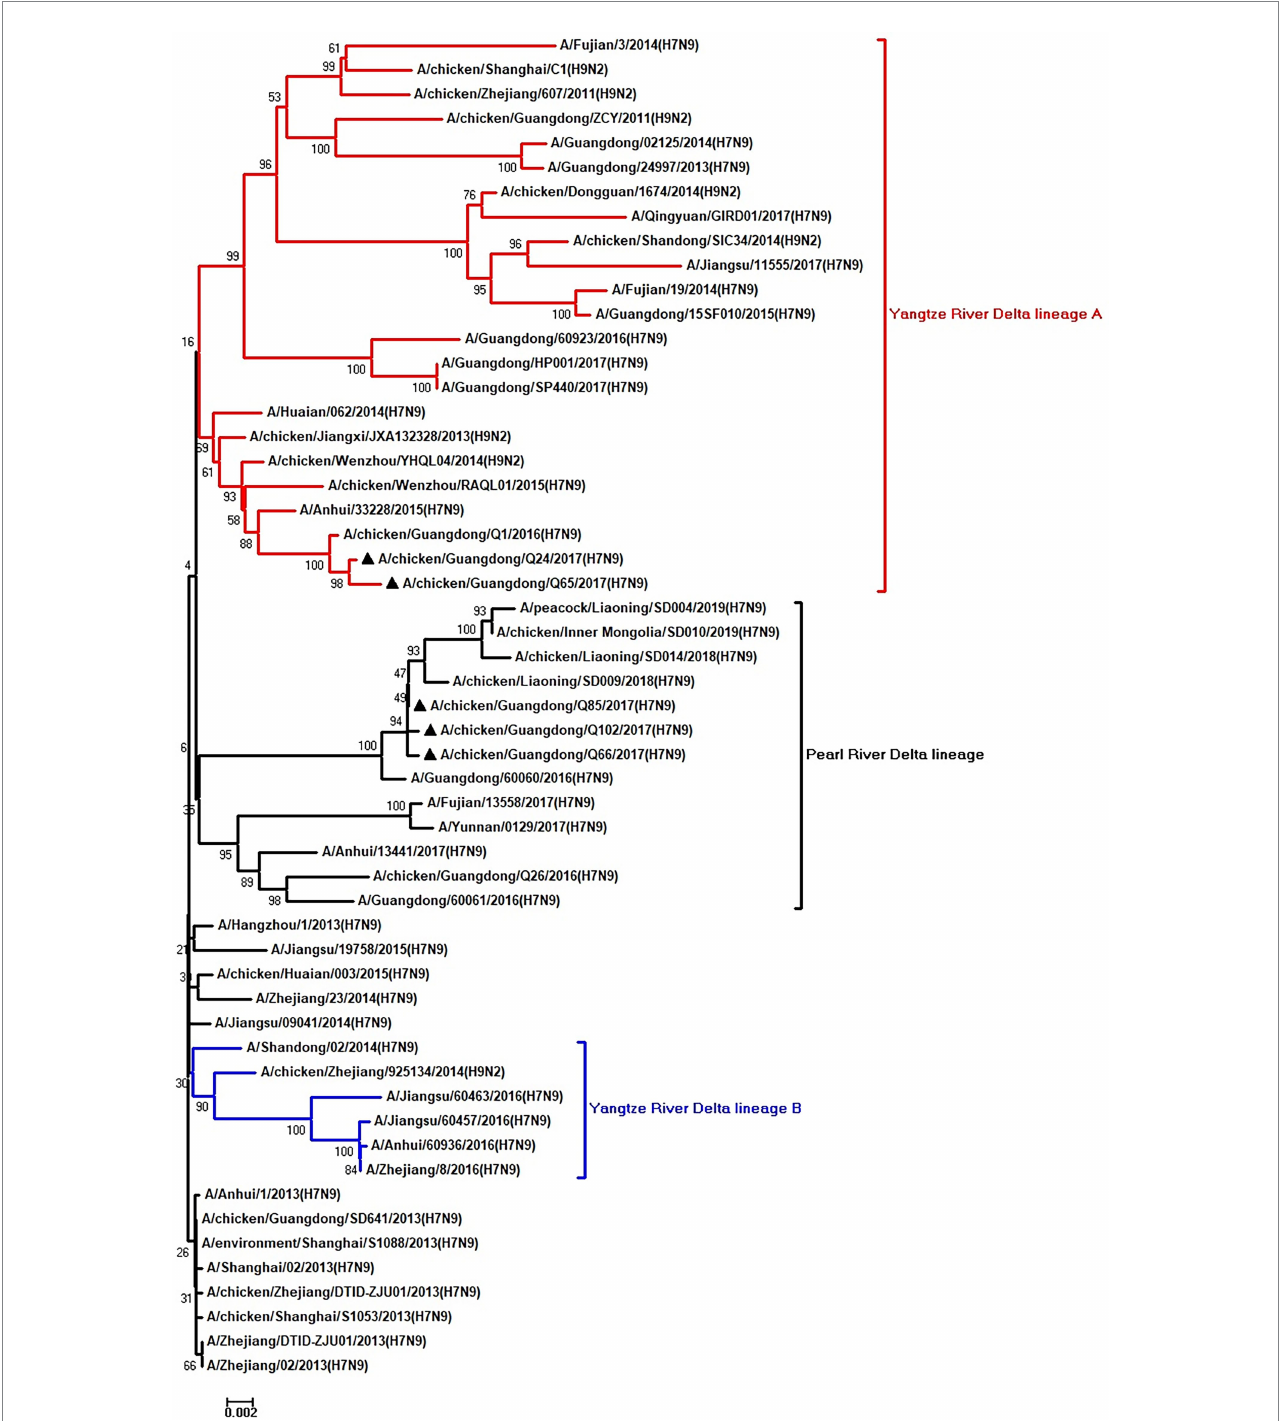
FIGURE 6 Phylogenetic analysis of PB1. The tree was constructed by using the neighbor joining method with the Maximum Composite Likelihood model and MEGA version 5.2 (www.megasoftware.net/) with 1,000 bootstrap replicates based on the following sequences: PB1: nt 25–2,298. Except our five isolates, other virus sequences were downloaded from GenBank. Triangles indicate the viruses characterized in this study. The scale bar indicates the branch length and corresponds to 0.002 estimated amino acid substitutions per